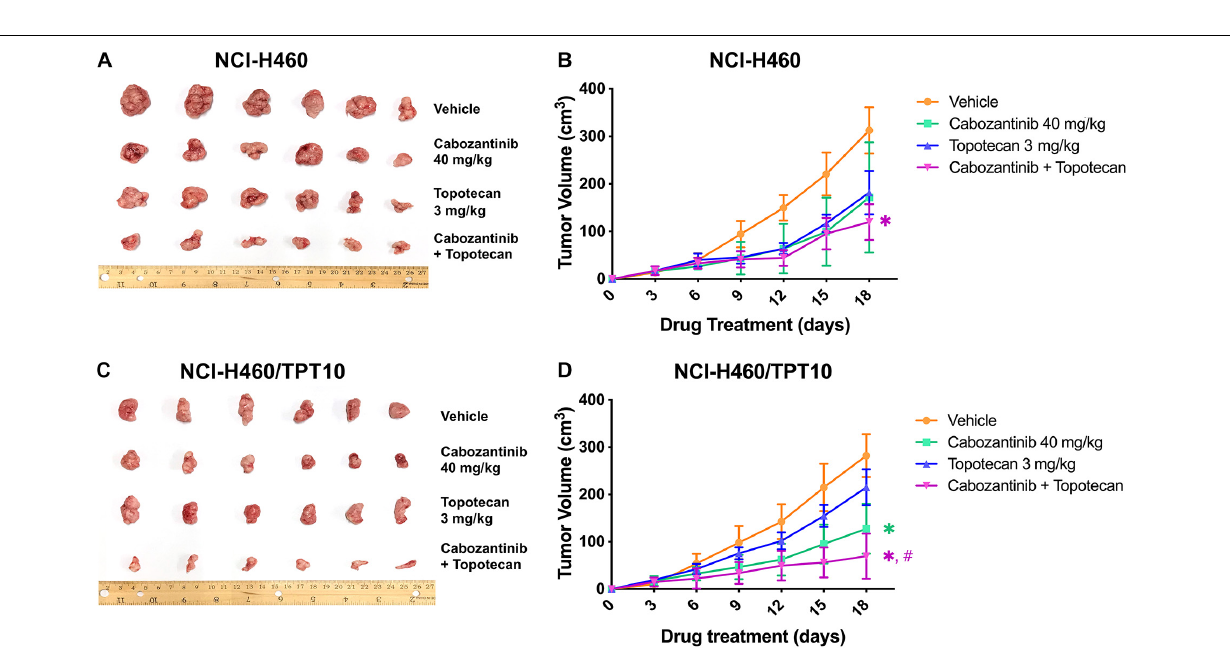
FIGURE 4 | Effect of topotecan and cabozantinib on the growth of NCI-H460 and NCI-H460/TPT10 tumors in male nude mice. (A,C) The images of resected tumors at the end of the treatment period from nude mice ( n = 6 per treatment group) implanted with NCI-H460 and NCI-H460/TPT10 tumors. (B,D) The changes in NCI-H460 tumor volume and NCI-H460/TPT10 tumor volume throughout the study after the implantation. Data points and error bars represent the mean and SD of tumor volume ( n = 6). ∗ and # signs were shown in the same color scheme as the figure legends. ∗ p < 0.05 versus the vehicle group; # p < 0.05 versus the topotecan only